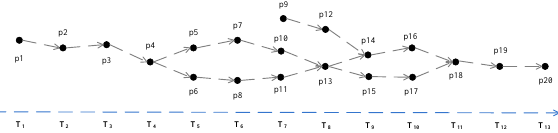
Figure 1. An example of complex